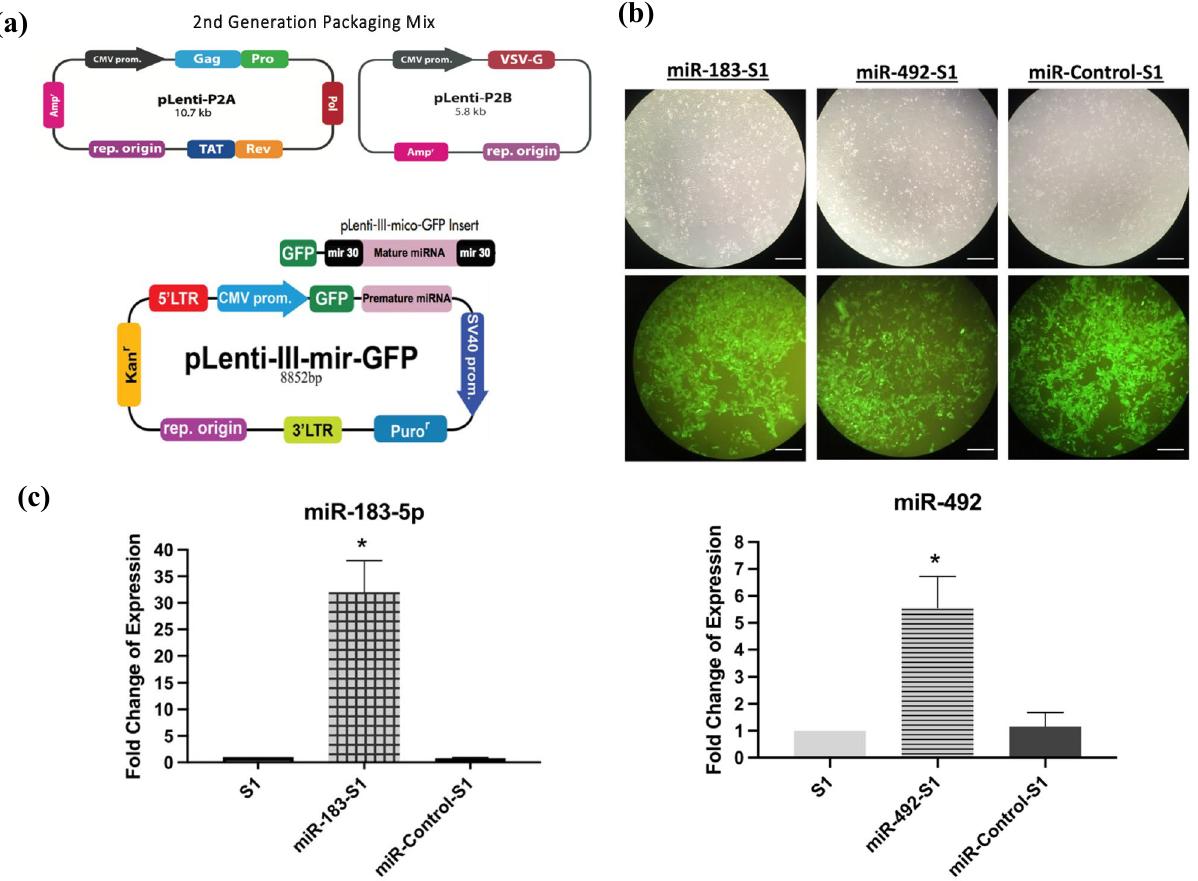
Figure 2. Stable over-expression of miR-183-5p and miR-492 in non-neoplastic S1 cells using pLenti-III-miR- GPF tagged vectors. ( a ) The maps specific to pLenti-III-miR-GPF tagged vectors as well as the 2nd generation packaging mix used. ( b ) Microscopy images showing pLenti-III-miR-GFP viral infection in both miR-183-S1 and miR-492-S1 infected cells on day 25 in culture (16 days post-puromycin treatment at 0.5 ug/ul). The top panel shows phase contrast images while the bottom one shows fluorescence images. pLenti-miR-control (empty vector), miR-Control-S1, was used as a control. ( c ) RT-qPCR quantification showed that over-expressing miR- 183-5p and miR-492 in S1 cells significantly upregulated the expression of miR-183 by 32 folds and miR-492 by 6 folds, respectively. This was done in triplicates as compared to uninfected S1 controls and miR-Control-S1 cells in 3D cultures using RNU6B as an endogenous control. * denotes a p-value < 0.05 using one-tailed unpaired